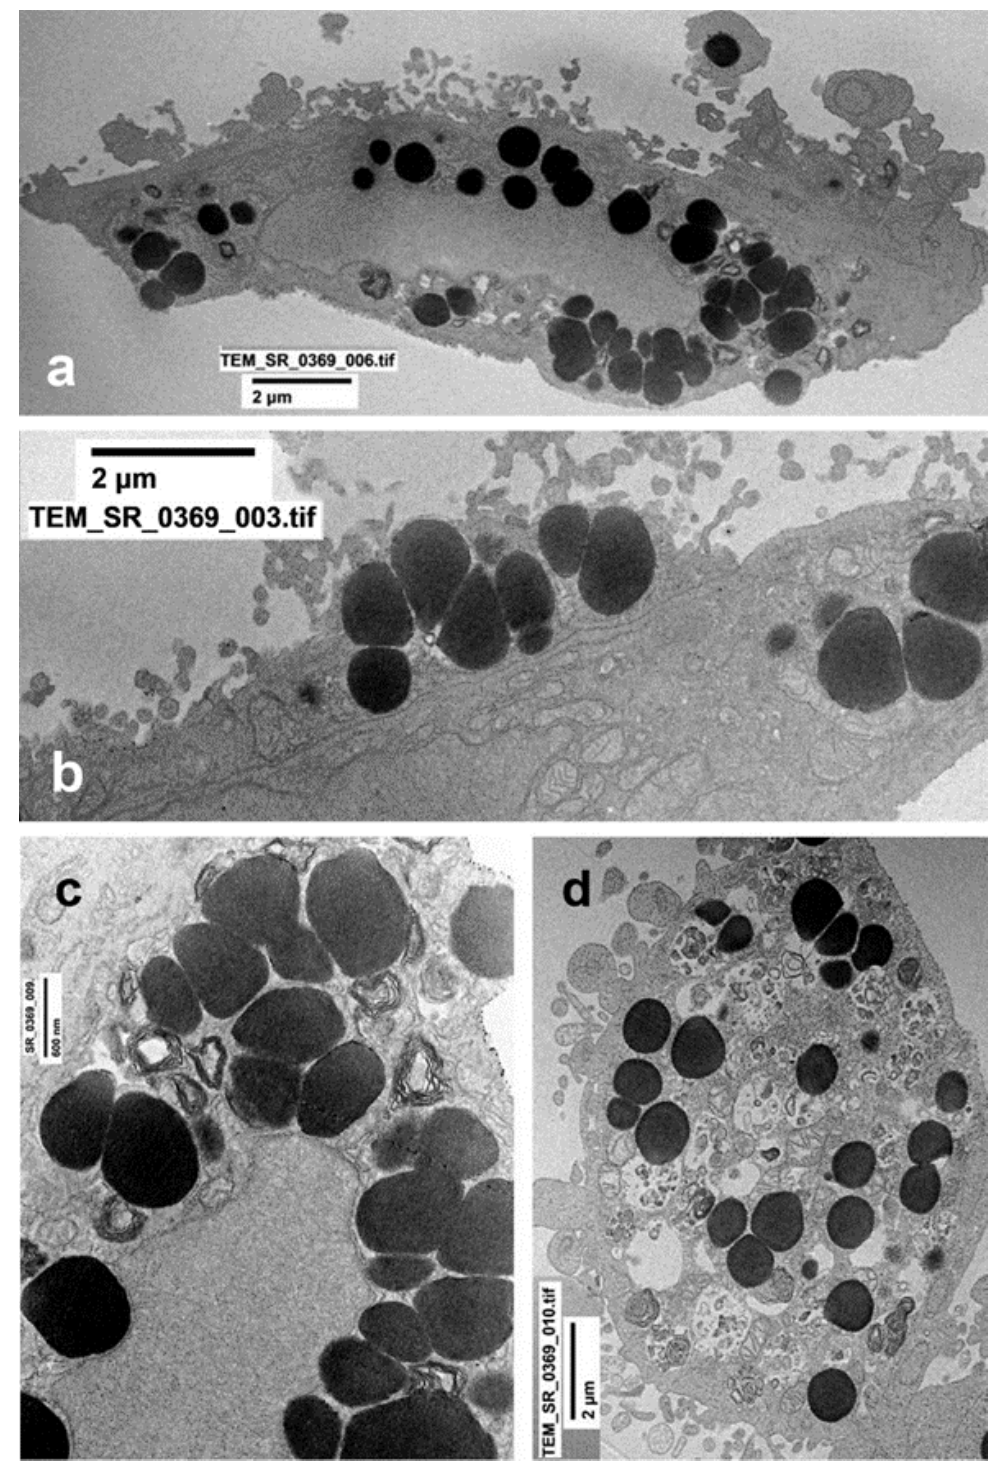
Figure 3. ( a – d ) Cells treated with nicotine alone for 24 h. ( a ) The majority of cells were larger than control, with abundant cytoplasm and numerous electron-dense granules of immature surfactant. Occasionally, granules appeared to be released from cytoplasm (arrowheads) or as microvescicles (arrow). ( b ) Detail of peripheral large dense granules during secretion. ( c ) Cytoplasm, as compared to untreated cells, contained a larger number of osmiophilic lipid bodies. ( d ) Three types of granules were observed: 1. very dense and homogeneous; 2. decreased density and homogeneity; 3. vacuoles containing myelin-like osmiophilic membranes (final differentiation).